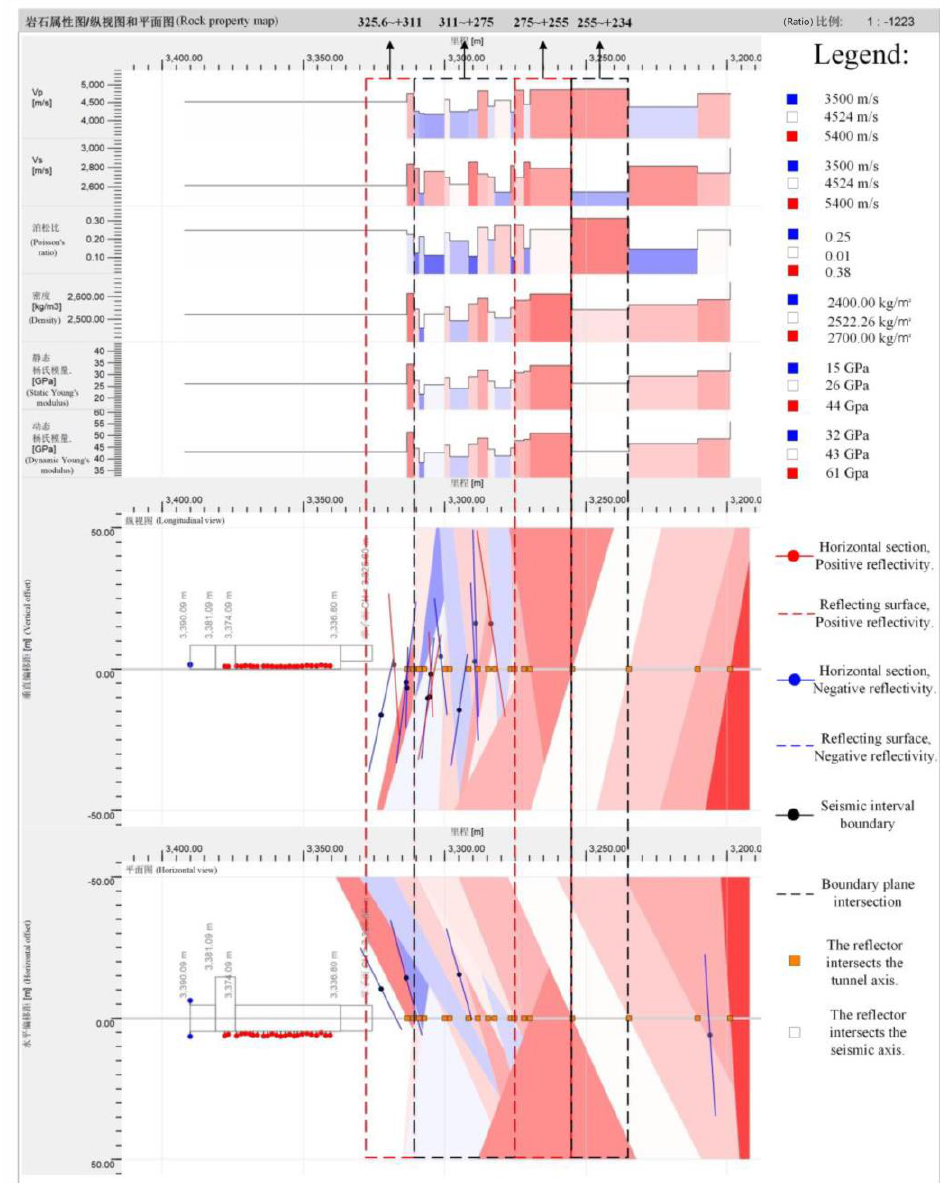
Figure 3. Mileage 325.6~+ 234 segment TSP output result.